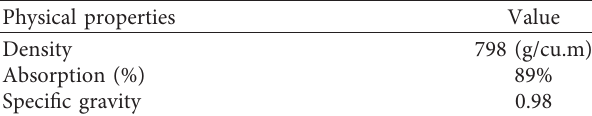
Table 2: Physical Properties of waste paper mass. Table 4: Mix proportions for the waste paper